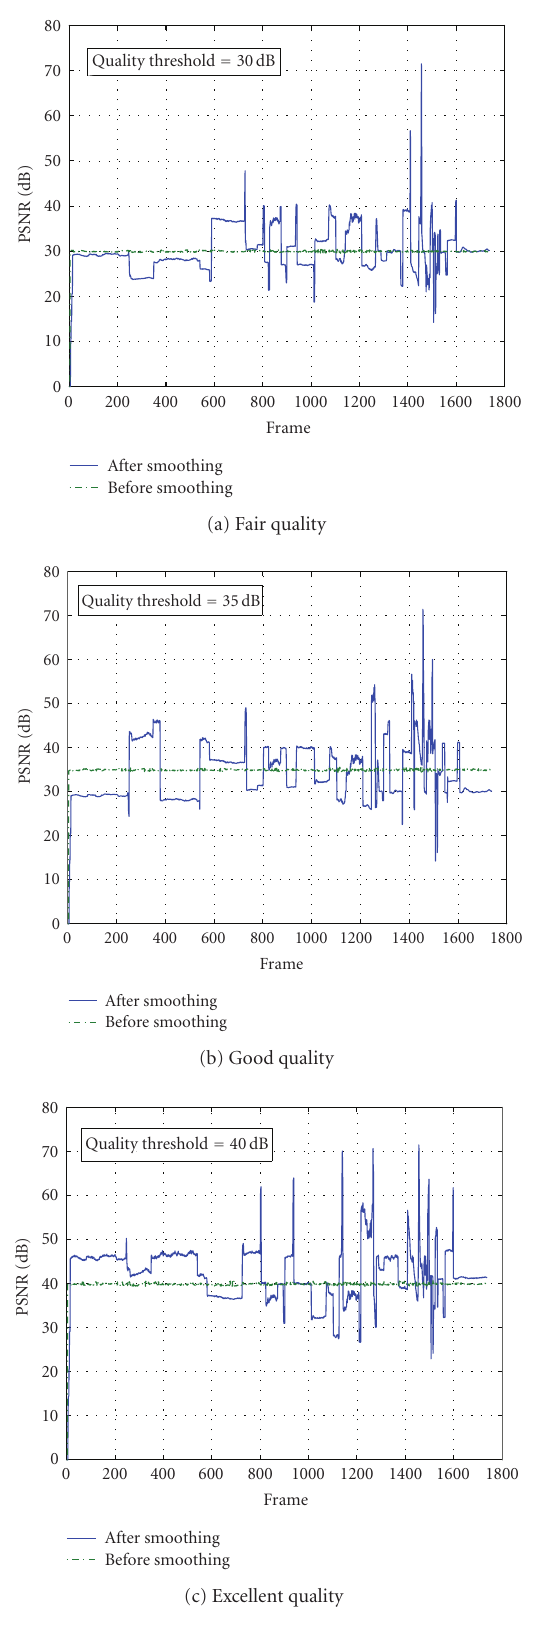
Figure 15: Actual PSNR quality before and after filtering and quan-